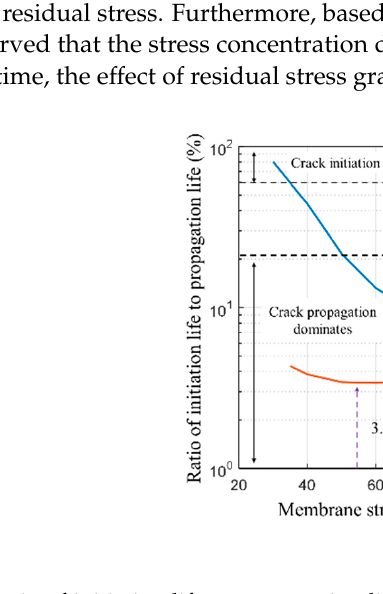
Figure 20. Calculation results of S − N curve of total fatigue life. ( a ) S − N curve of total life with different notch radius without residual stress; ( b ) S − N curve of total life with different notch radius with residual stress.